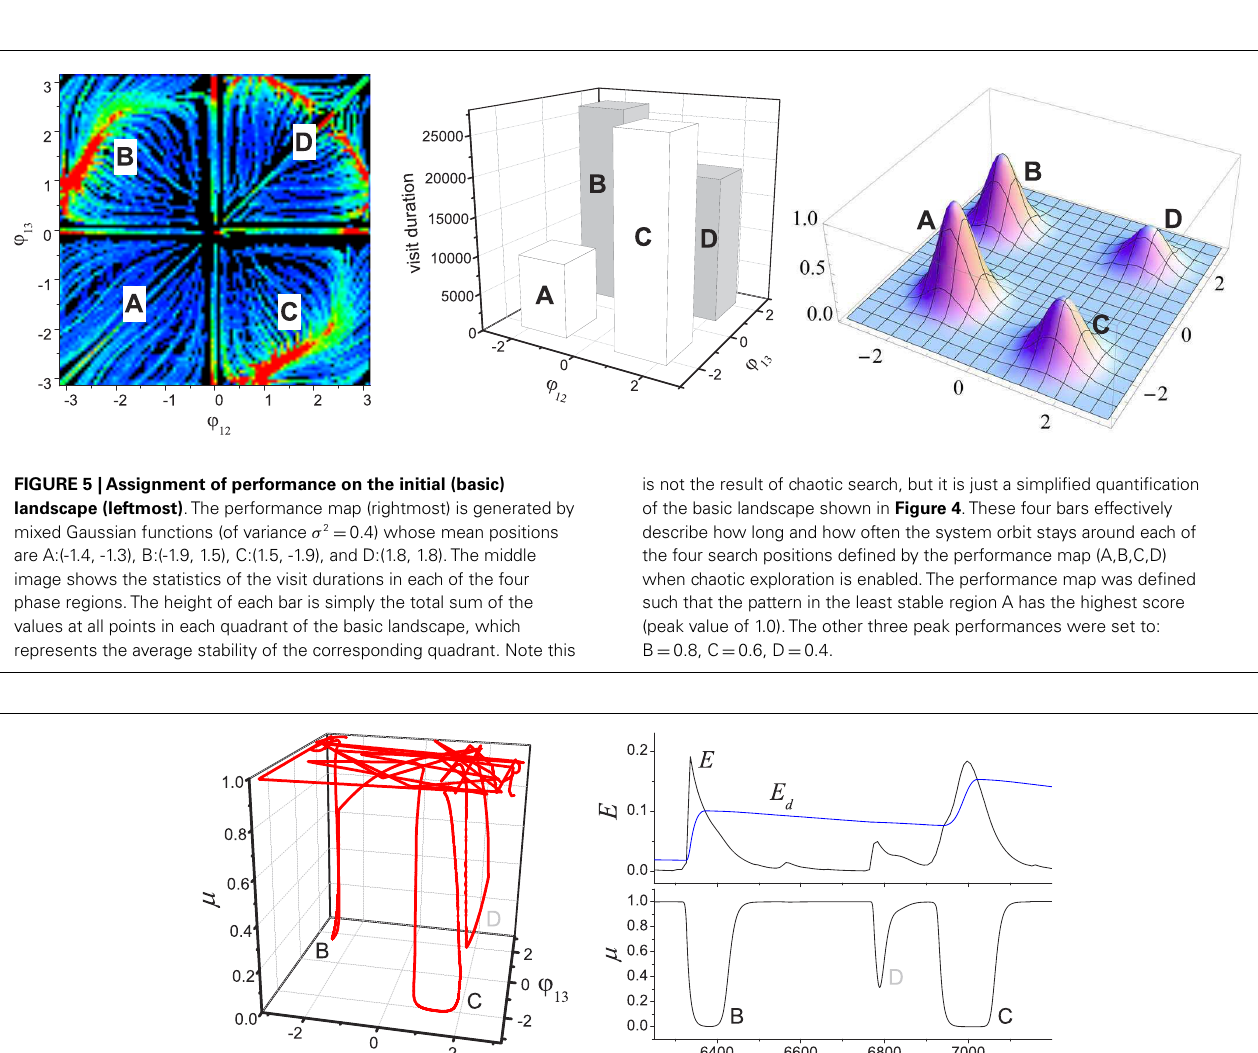
bifurcation parameter ( µ ).The system orbit jumps from the stable regimes near pattern B to pattern C, where the complete approach to be near pattern D failed due to the insufficient level of E / E d